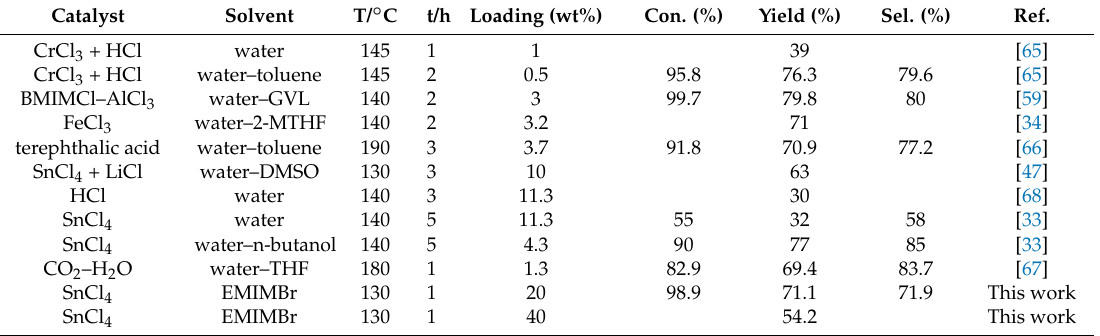
Figure 7. Effect of reaction temperature on the dehydration of xylose into furfural. Reaction conditions: 200 mg of xylose was dissolved in 1000 mg of EMIMBr; molar ratio of SnCl 4 :xylose = 1:10. Table 3. Comparisons of catalytic performance of the EMIMBr/SnCl 4 system with representative catalytic systems for conversion of xylose to